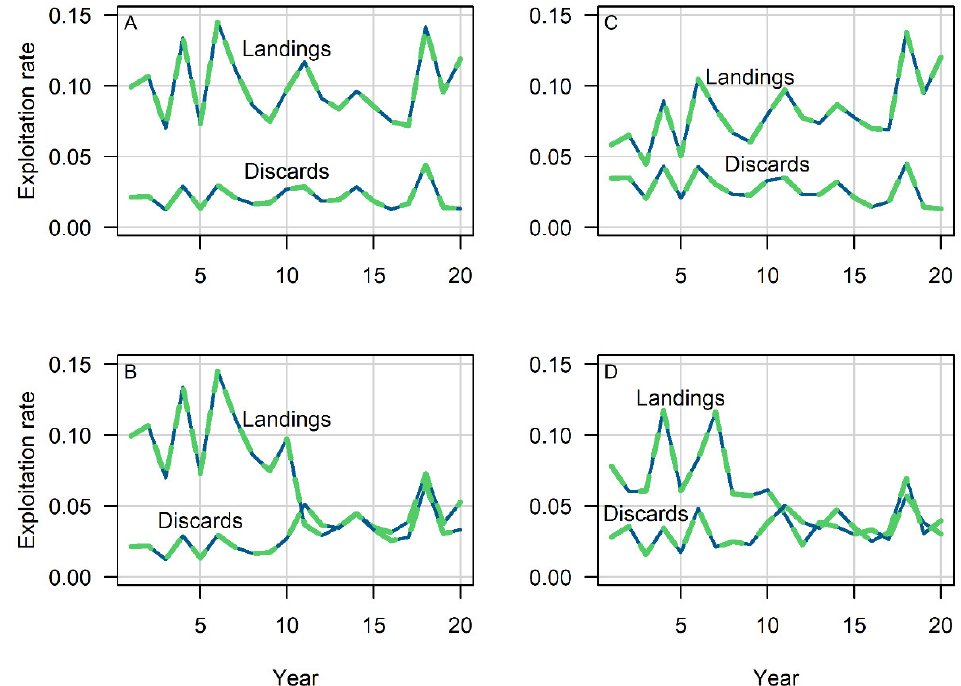
Figure 4. Exploitation rates associated with landings and dead discards, as indicated on panels, in simulations using the retention model (blue, solid) or separate-fleet model (green, dashed). ( A ) Simulation 1. ( B ) Simulation 2. ( C ) Simulation 3. ( D ) Simulation 4. Note that blue and green curves overlap in each panel.